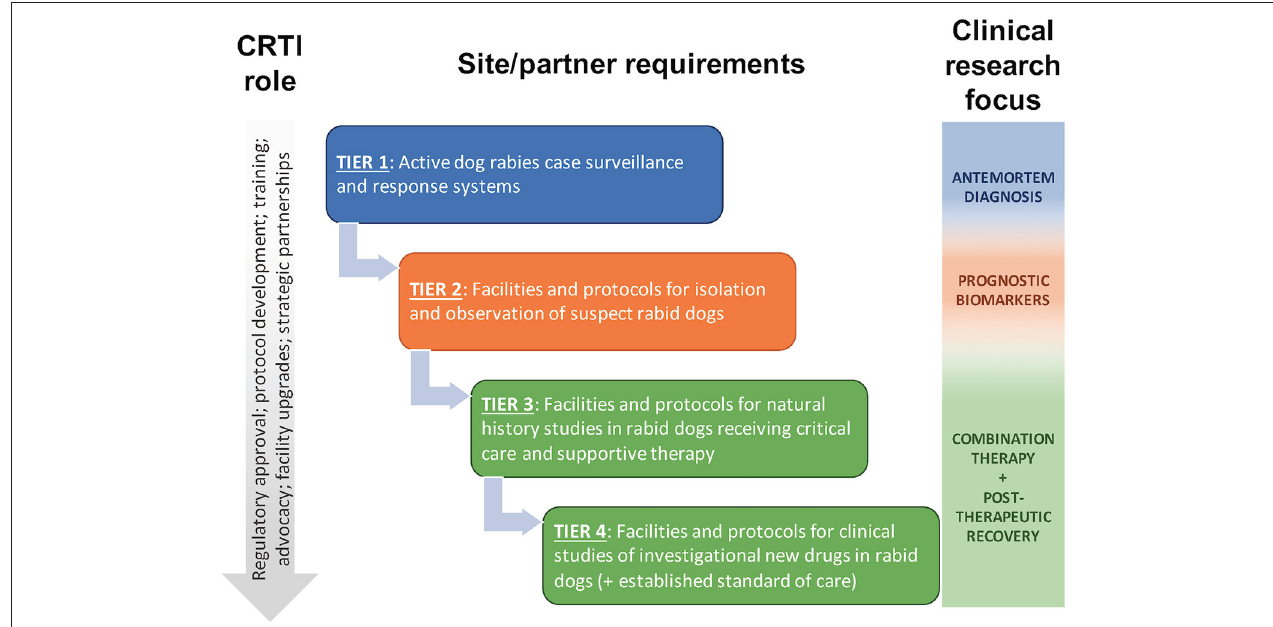
FIGURE 1 | The Canine Rabies Treatment Initiative (CRTI) will implement a tiered approach to clinical research on rabies in naturally infected dogs, progressing to clinical studies of investigational new drugs in dogs receiving critical care and supportive therapy that mimic the human clinical scenario. Naturally infected dogs provide a higher and more predictable caseload than human patients, providing opportunities for additional clinical research to supplement preclinical and human clinical